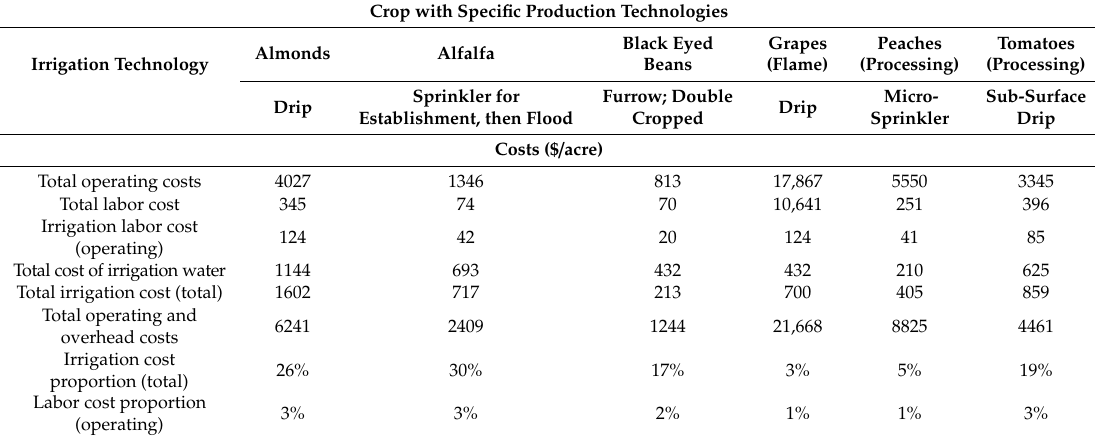
Table 1. Crop production costs, selected California Central Valley (San Joaquin south region) crops [24] and expenditure shares. 2016 U.S. dollars.